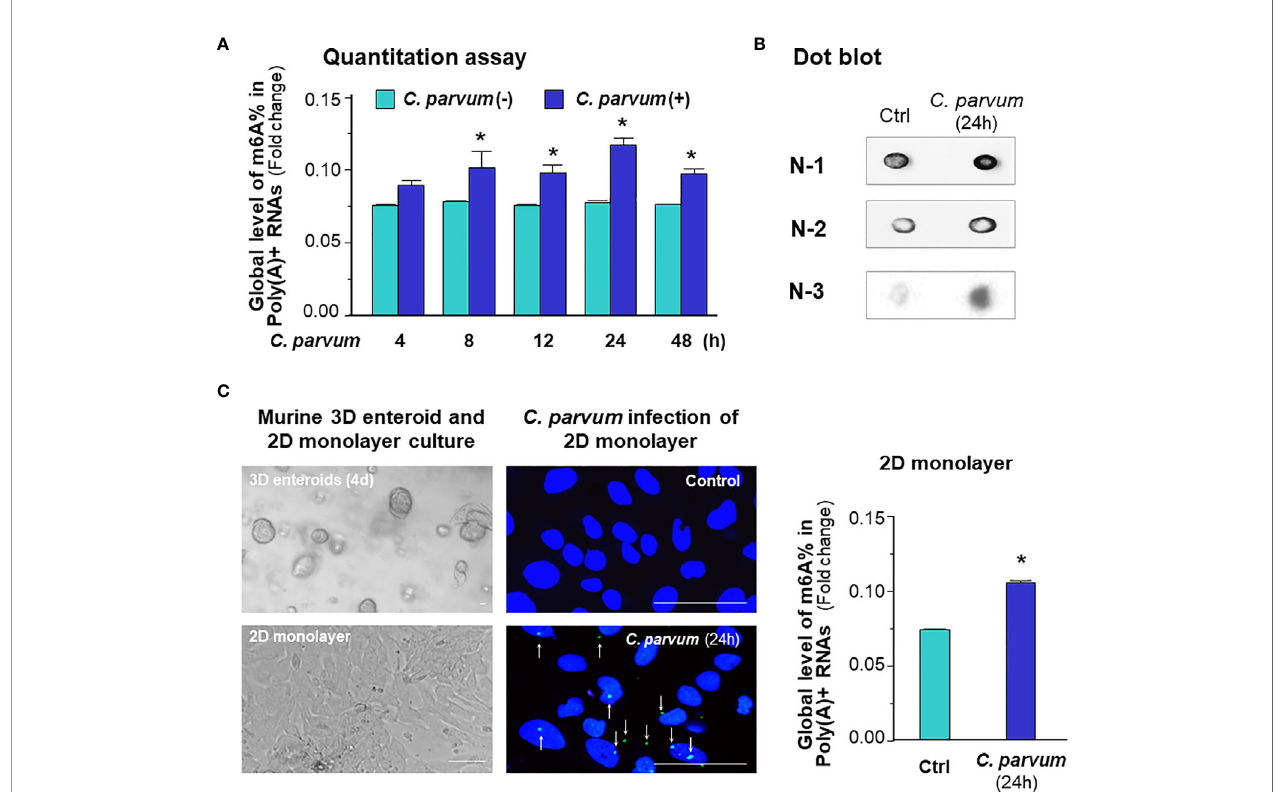
FIGURE 1 | C. parvum infection causes a global increase in m 6 A RNA methylation in intestinal epithelial cells. (A) Increase of m 6 A RNA methylation in IEC4.1 cells following C. parvum infection. Cells were exposed to C. parvum for up to 48 h and RNA was collected for m 6 A methylation measurement with the m 6 A RNA methylation quantitation assay. (B) Dot blot measurement of m 6 A RNA methylation in IEC4.1 cells following C. parvum infection. Cells were exposed to C. parvum infection for 24 h and RNA was collected for dot blot with anti-m 6 A. Gel images from three independent experiments are shown. (C) Increase of m 6 A RNA methylation in 2D murine intestinal epithelial monolayers following C. parvum infection. The crypt units of small intestinal epithelium from neonates of 5 days old were isolated and cultured into 2D monolayers followed by exposure to C. parvum infection for 24 h, as shown by phase and immuno fl uorescence microscopy ( C. parvum parasites were stained in green as indicated by arrows). Intestinal epithelial 2D monolayers were exposed to C. parvum for 24h and RNA was collected for m 6 A methylation measurement with the m 6 A RNA methylation quantitation assay. Bar = 20 m m. Data represent three independent experiments. *p < .05 vs the non- infected